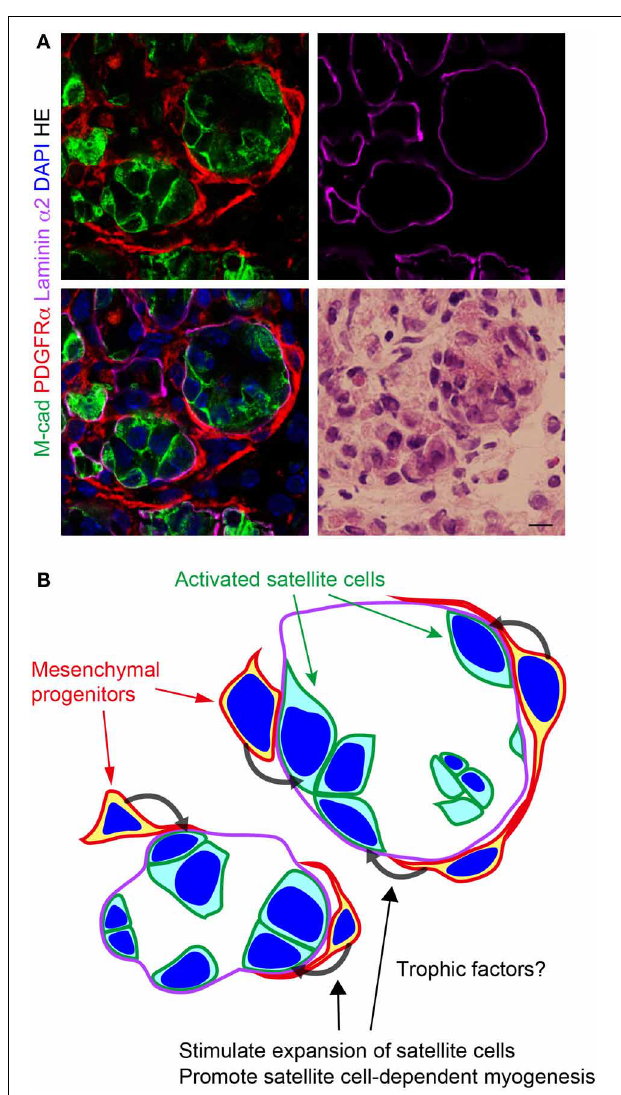
FIGURE 3 | Localization of PDGFR α + mesenchymal progenitors in regenerating muscle. (A) Fresh frozen section of regenerating muscle subjected to immunofluorescence staining for M-cadherin (M-cad), PDGFR α , and laminin α 2, and subsequently to HE staining. Scale bar: 10 μ m. (B) Schematic view of (A) . Mesenchymal progenitors encircle the sheath of basement membrane in which satellite cells undergo active myogenesis. Mesenchymal progenitors stimulate satellite cell expansion and promote satellite cell-dependent myogenesis. Factors responsible for these effects remain to be